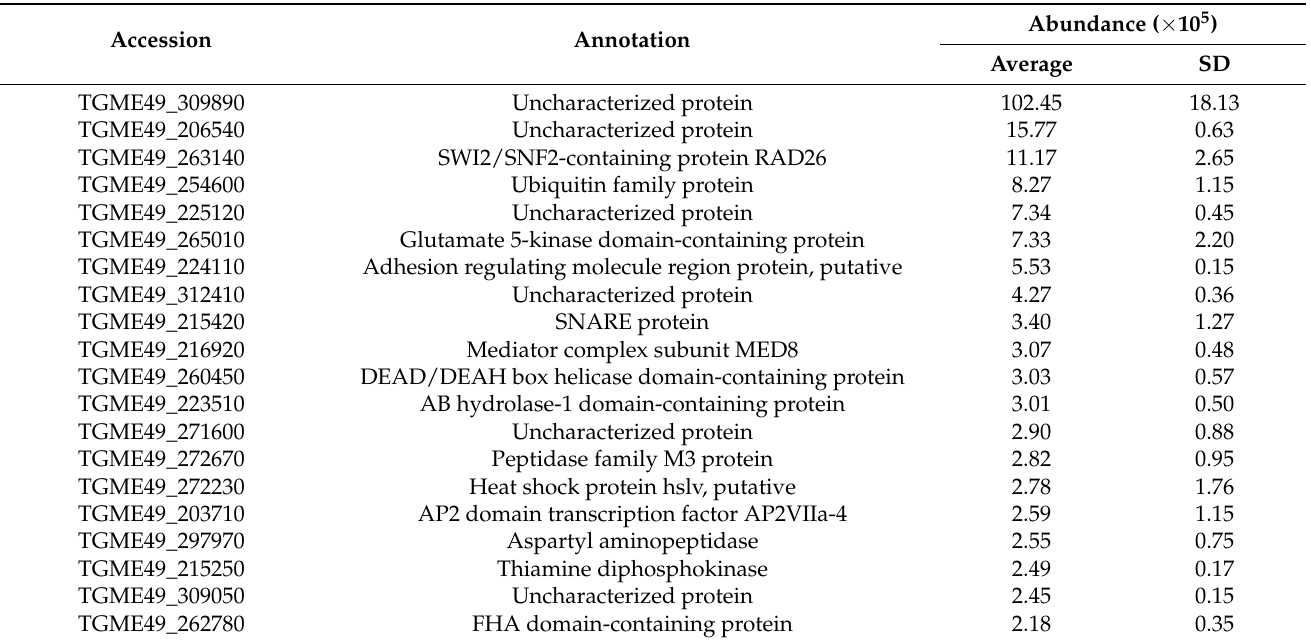
Table 2. Twenty most abundant proteins identified with high FDR confidence, only in the MOB1-pull down, in all three